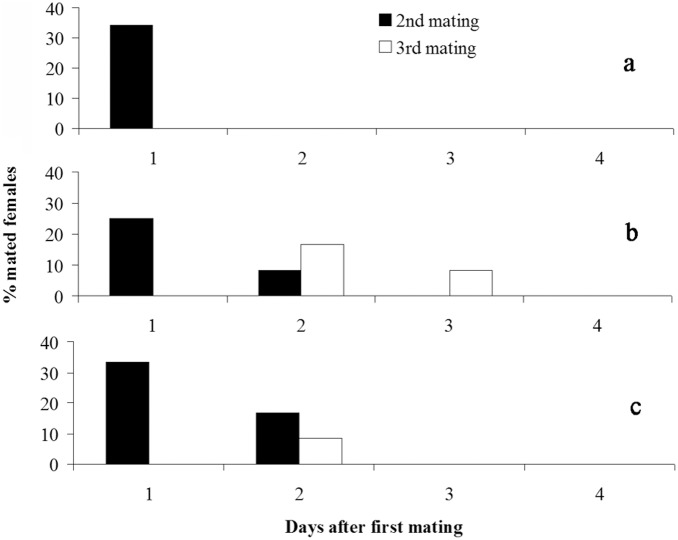
Remating patterns of females in treatment Novel (a), Paired (b) and Multiple (c) treatments in S. litura.